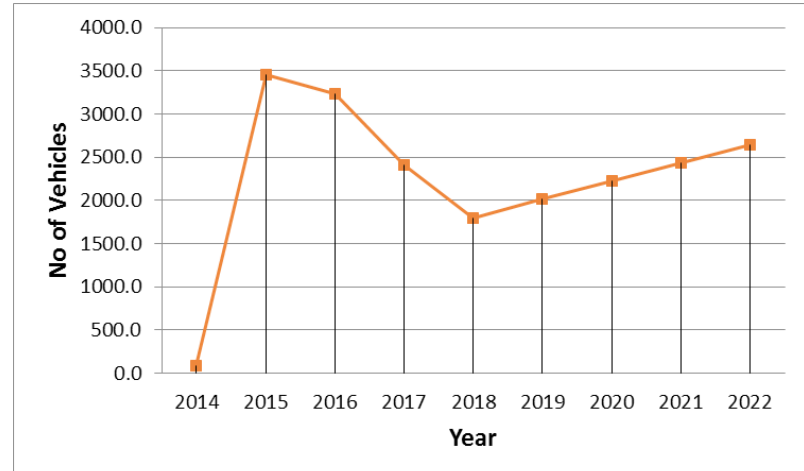
Figure 2: EV predictions up to 2022.